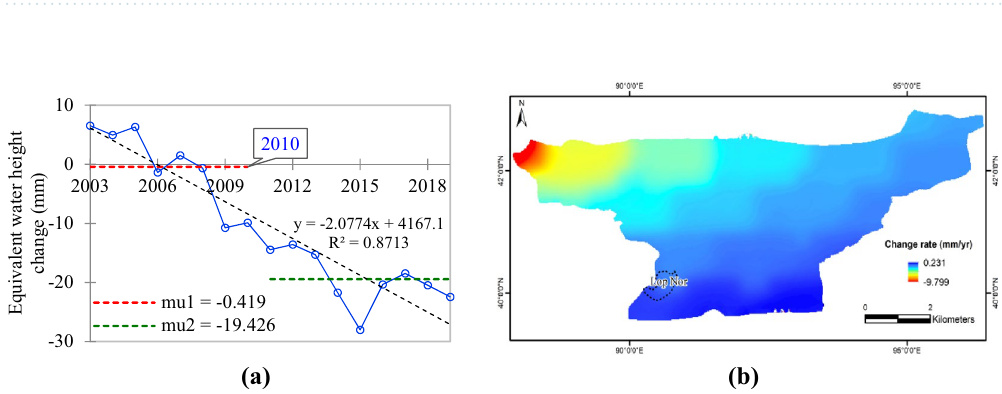
Figure 3. Variation trend and tipping point change (a) and spatial change rate (b) of equivalent water height of groundwater in the Lop Nur region from 2003 to 2019. The right figure was generated by ArcGIS v10.7